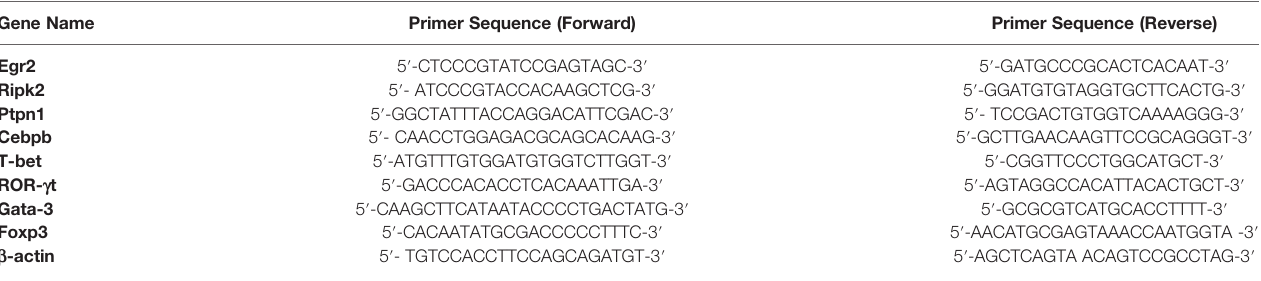
TABLE 1 | List of primers used in real-time